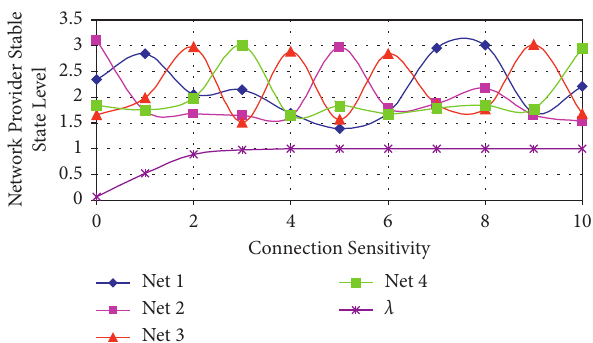
Figure 24: Handover process and network activities response (selection probability) to dynamic state selection, as a function of sensitivity.